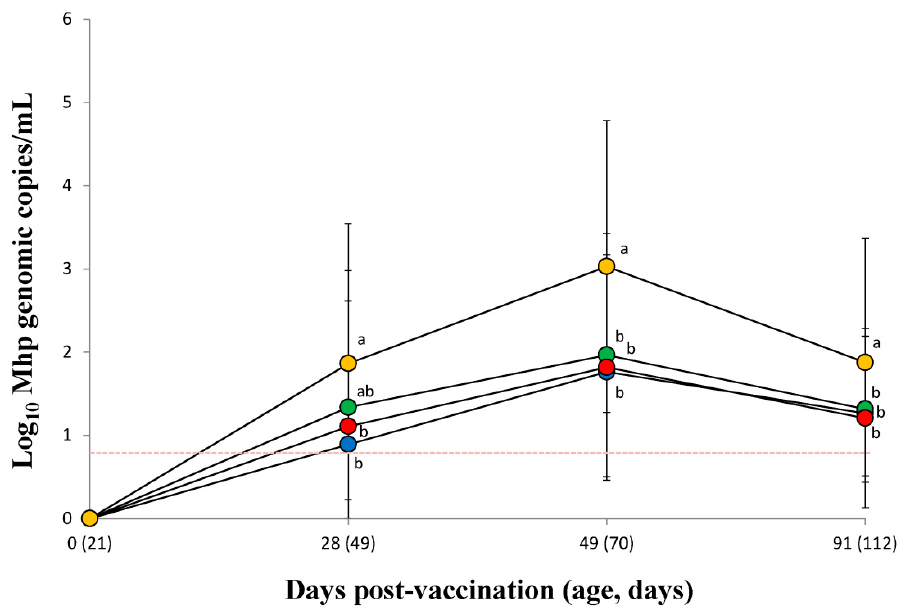
Figure 4. Mean values of the genomic copy number of Mycoplasma hyopneumoniae DNA in larynx from VacS ( • ), VacPulse ( • ), VacEPIG ( • ), and UnVac ( • ) groups. Variation is expressed as the standard deviation. The detection limit of the assay is 6.3 genomic copy numbers of M. hyopneumoniae (red dotted line). Different superscripts (a and b) indicate significant ( p < 0.05) different among 4 groups.